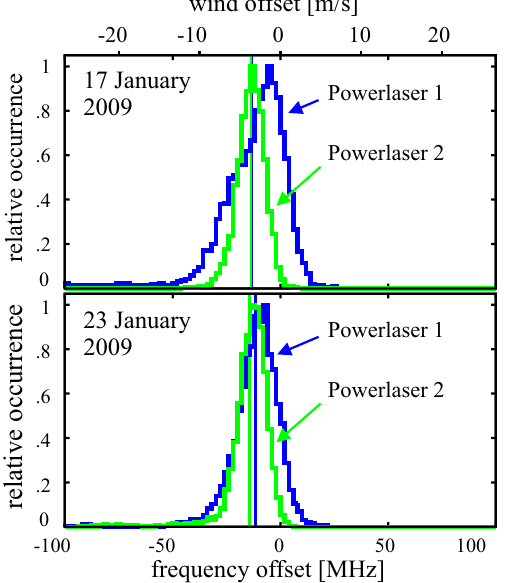
Fig. 7. Histogram of pulsed laser frequency offset to seed laser during the measurements on 17 January 2009 (upper pannel) and 23 February 2009 (lower pannel). The mean values are indicated by vertical bars. The apparent wind offset is indicated in the upper scale. The mean apparent wind offset is taken into account when deriving the actual wind profile.